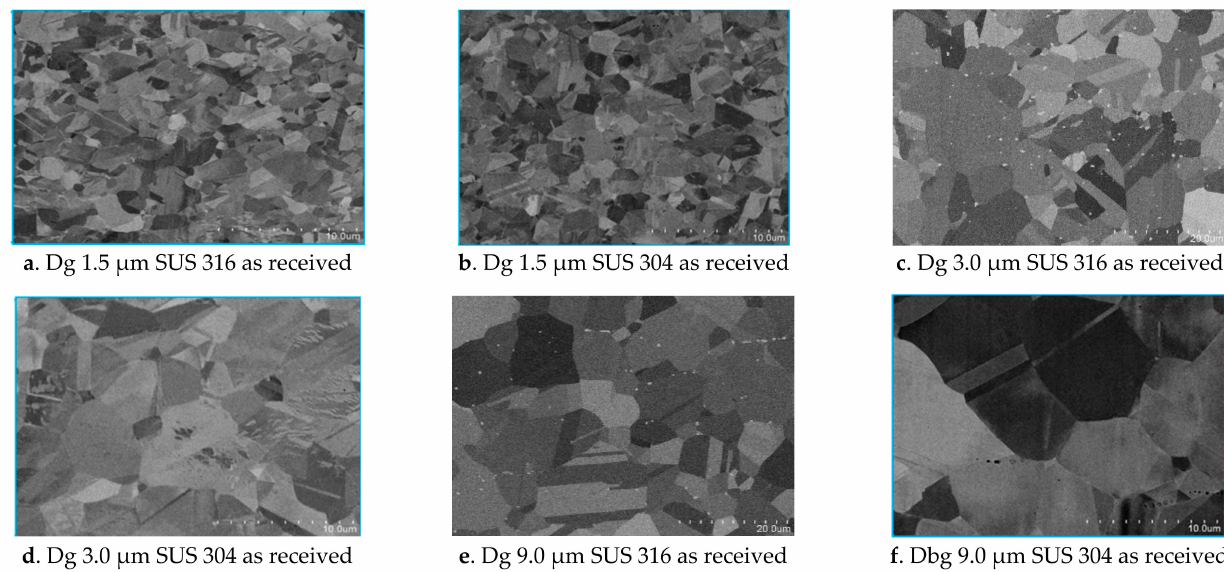
Figure 1. SUS 304 ( b , d , f ) and 316 ( a , c , e ) thin metal foils with different grain sizes (Dg) as received.